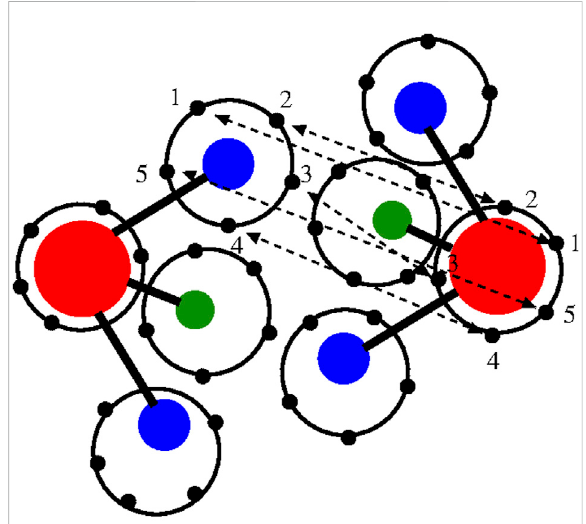
FIGURE 1 Graphical illustration of the path integral/polymer ring representation of two interacting water molecules of the TIP4P 4- sitemodelusedinthiswork(Habershonetal.,2009).Oxygen(red), hydrogen(blue),andadditionalsitemodel(green).Eachsiteis representedbyapolymerring;forgraphicalconvenience,only fi ve beads per atom/site are drawn although 30 beads per atom/site are used in the real simulation. Atoms of different molecules interact through bead – bead interactions. The beads involved in the interatomic/intersite interactions are only the beads with the same label (here represented as 1, 2, 3, 4, and 5) of each atom/site. For simplicity, the oxygen – hydrogen interaction is illustrated. The interaction potential has a classical form as the potentials used in the atomistic simulation; however, in this case, the bead – bead interaction is scaled by the number of